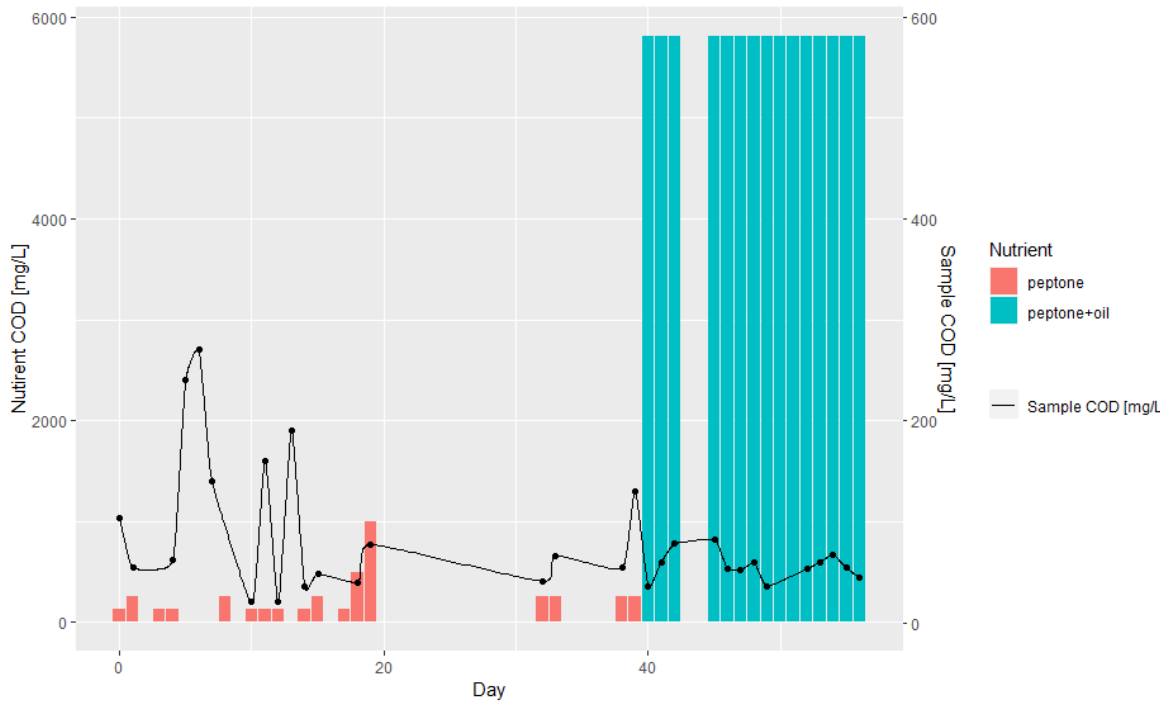
Figure 6. Relationship in time between chemical oxygen demand, nutrient medium, and biomass in a batch bioreactor.